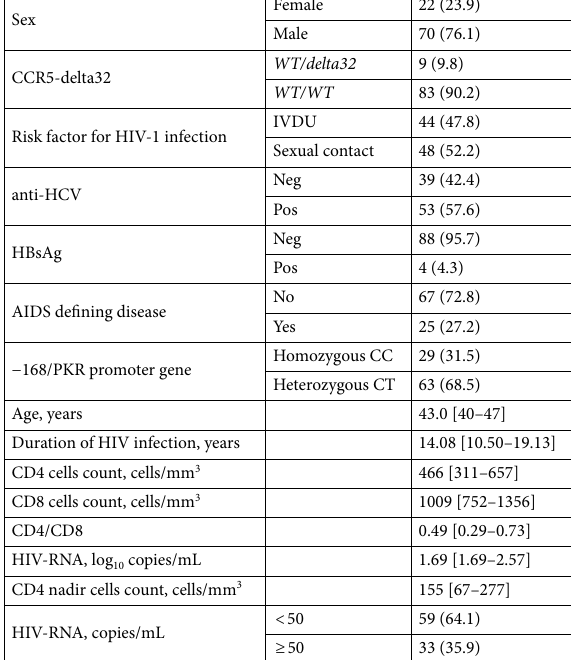
Table 1. Baseline characteristics of HIV-carriers. Median and interquartile range [IQR] have been used for quantitative variables, while categorical variables have been summarized as frequencies and percentages